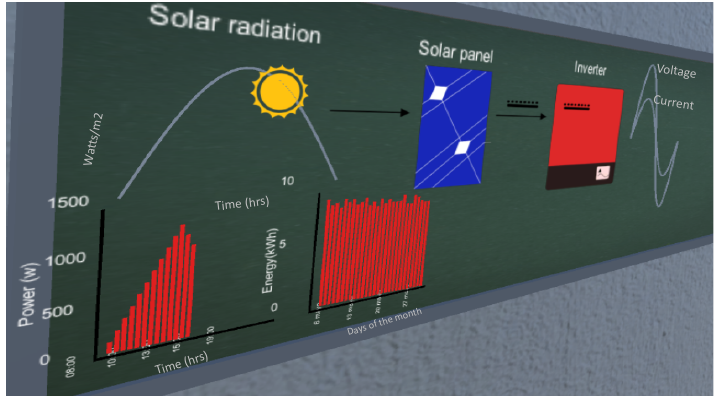
Figure 7. Emulating the PV system generation.